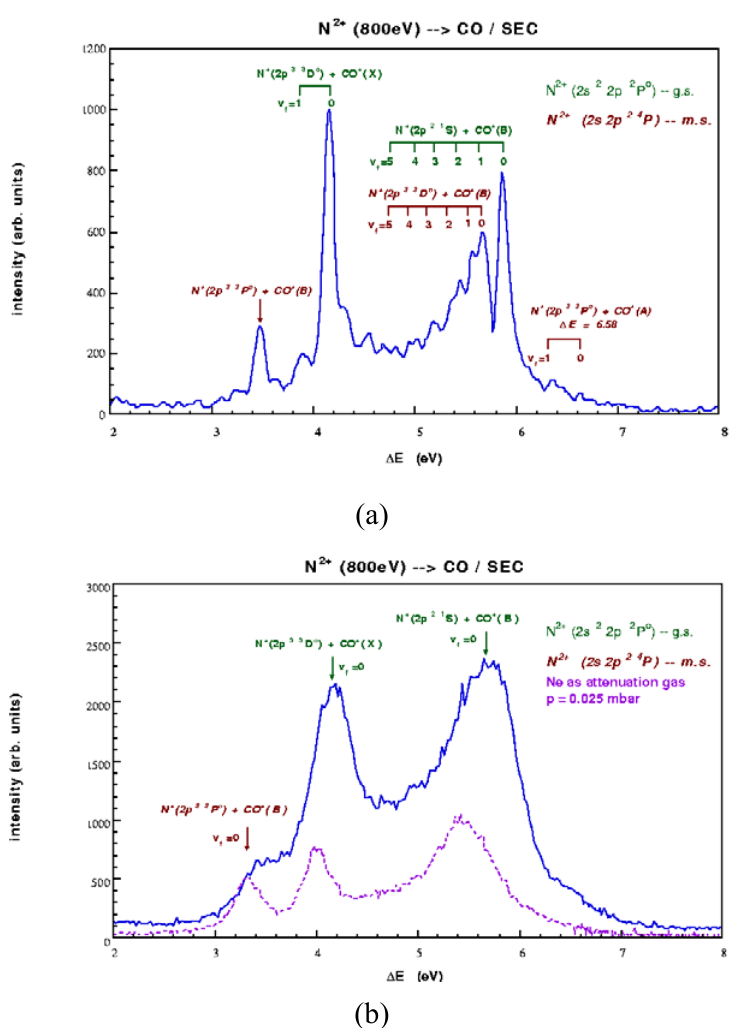
Fig. 3 : (a) TES for SEC in collisions of N 2+ with CO [12]. ( b) TES for SEC in collisions of N 2+